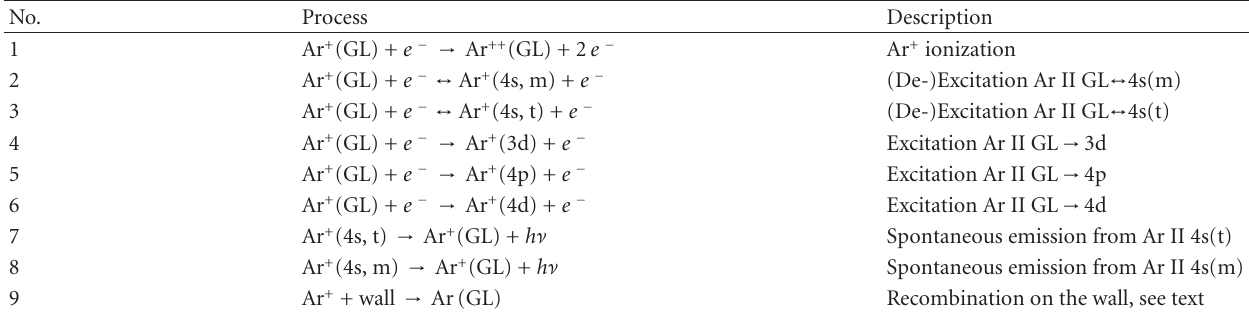
Table 5: Inelastic processes involving Ar II